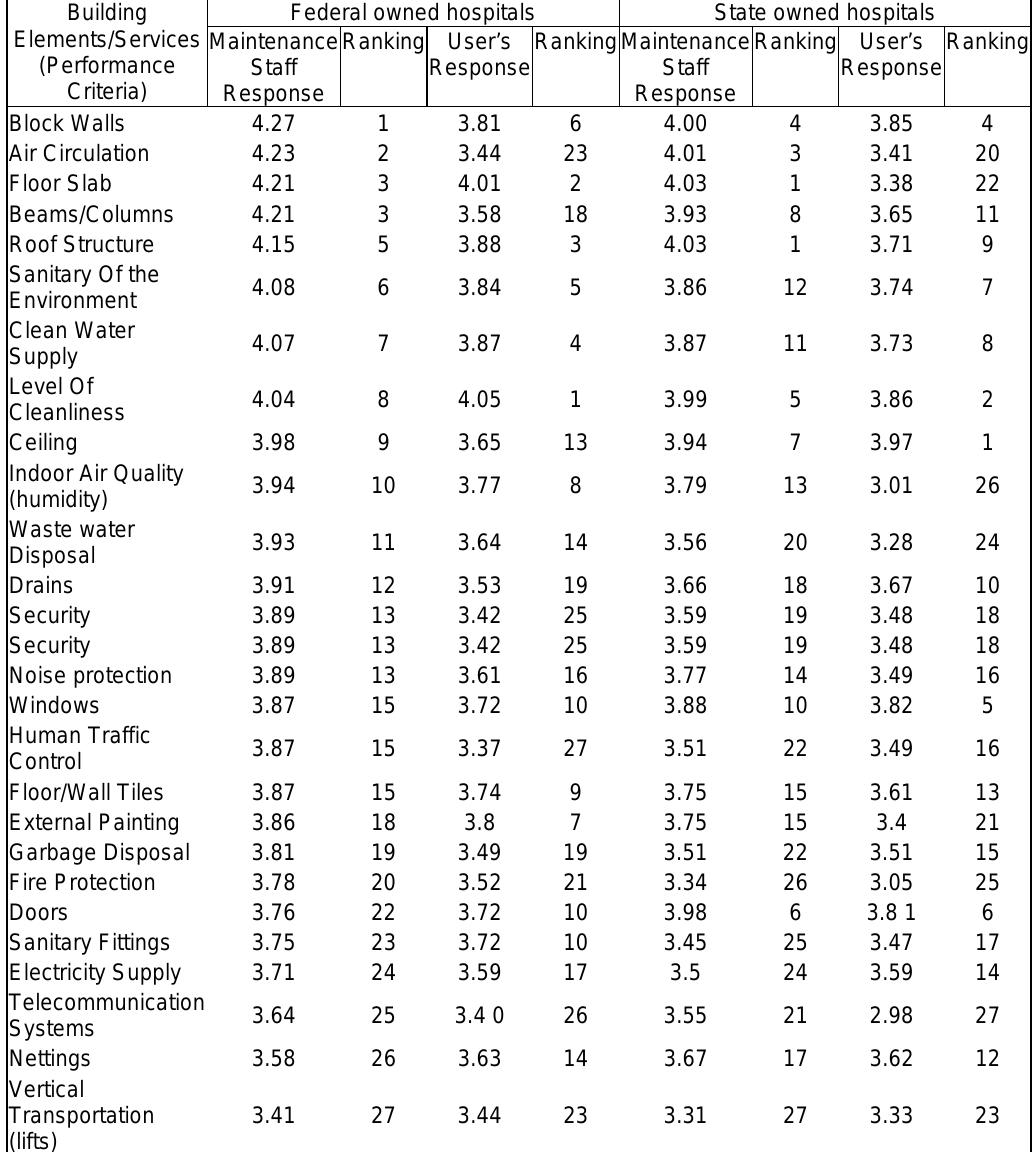
Table 8: Physical conditions of building elements and